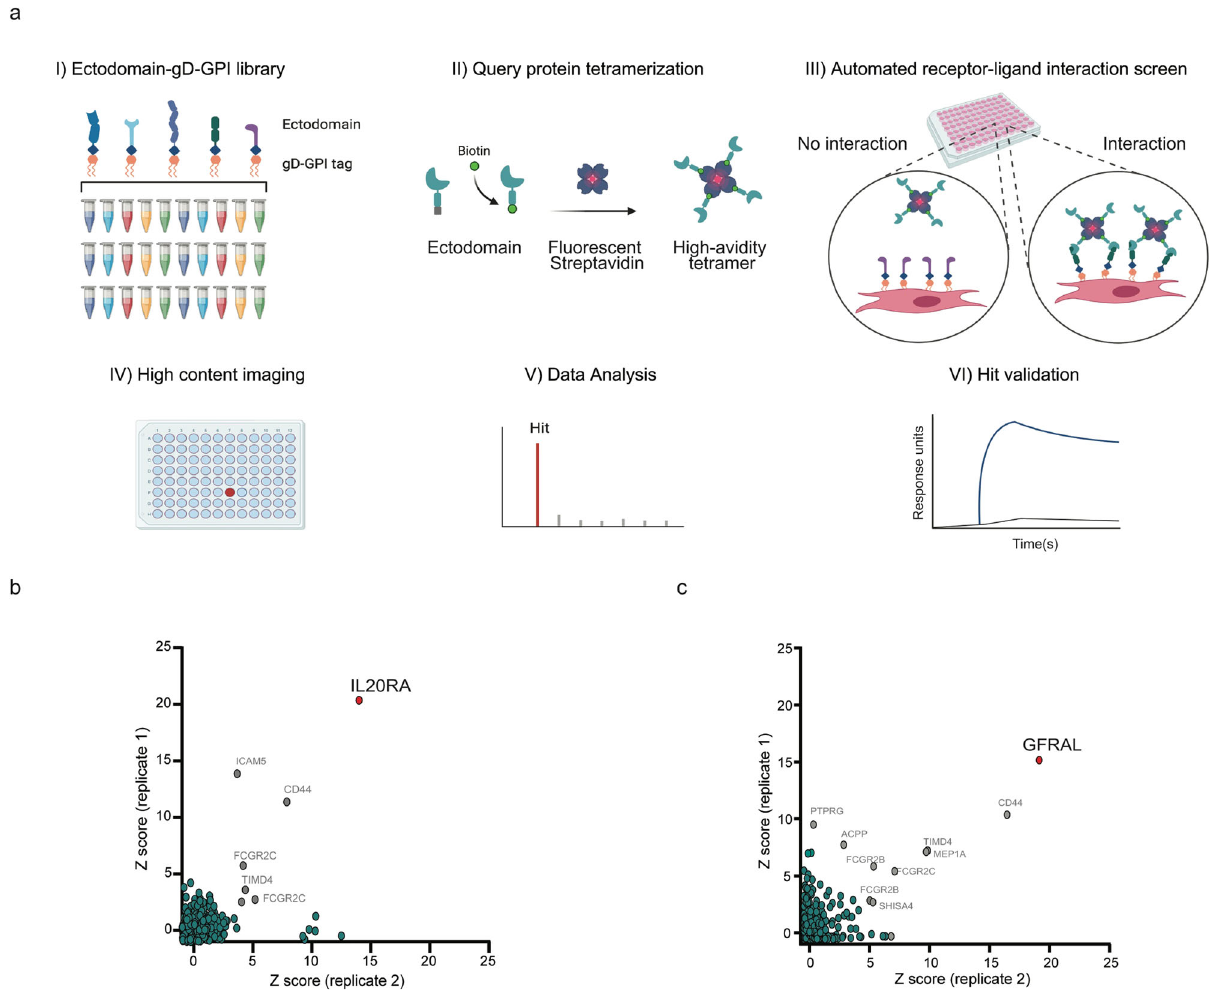
Fig. 2 An automated cell-based platform for enhanced receptor-ligand discovery. a Schematic representation of the automated cell-based platform for receptor-ligand discovery. (I) A library consisting of ≈ 1,200 unique single transmembrane-containing receptors and selected isoforms, expressed as ectodomains fused to a gD-GPI tag, was generated. (II) The query protein, expressed as avi-tagged ectodomain was biotinylated and subsequently tetramerized using fl uorescent streptavidin for increased binding avidity. A work fl ow for automated transfection, cell surface binding analysis, and high content imaging was implemented. (III) Individual receptors were transfected in mammalian cells, and binding of the query protein tetramer to the cell surface was detected by measuring fl uorescent signal. (IV) Images from individual wells are acquired using a high-content microscope. (V) Fluorescent signal intensity is calculated for each image and represents query protein binding to each receptor expressed on the plasma membrane. (VI) Following data analysis and hit calling, new interactors are con fi rmed using orthogonal techniques such as surface plasmon resonance. Unbiased screening using the receptor-ligand discovery platform identi fi es expected binding partners for the ( b ) receptor B7-H3/CD276 and ( c ) the secreted factor GDF15. Intersection plot represents binding of each receptor in the library, in duplicates. Each circle represents query protein binding to a unique receptor in the library. Unique high-scoring hits are shown in red circles. Hits shown in grey circles are empirically determined non-speci fi c fi rst tested B7-H3, an immune receptor deorphanized only recently 11 . As described, B7-H3 was expressed as a recombinant avi-tagged ectodomain for site-speci fi c biotinylation, followed by tetramerization using fl uorescently-labeled streptavidin. The B7- H3 ectodomain tetramer was then screened against the gD-GPI- tagged library using the automated cell-based platform (Fig. 2a).